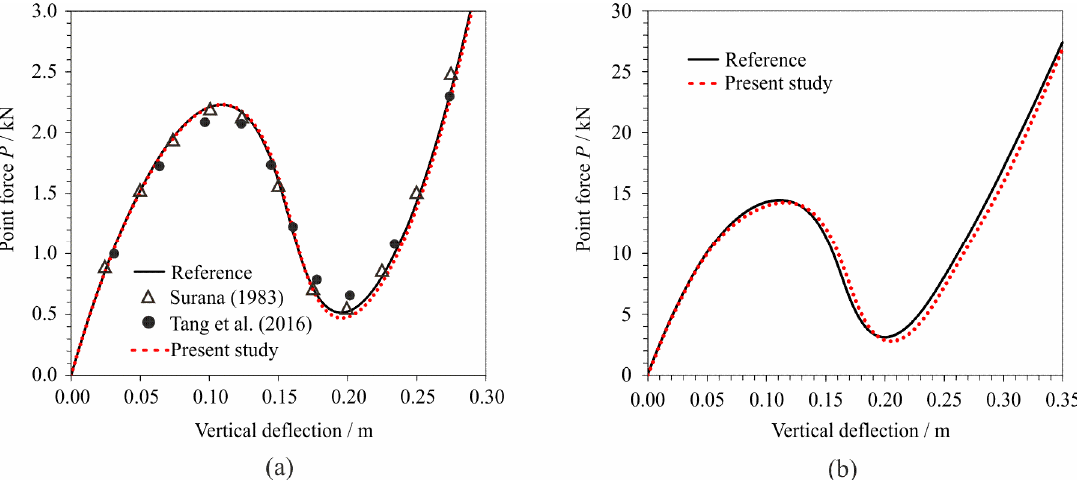
Figure 20. Vertical deflection in relation to the point force of the cylindrical roof: ( a ) linear analysis; ( b ) non-linear analysis.